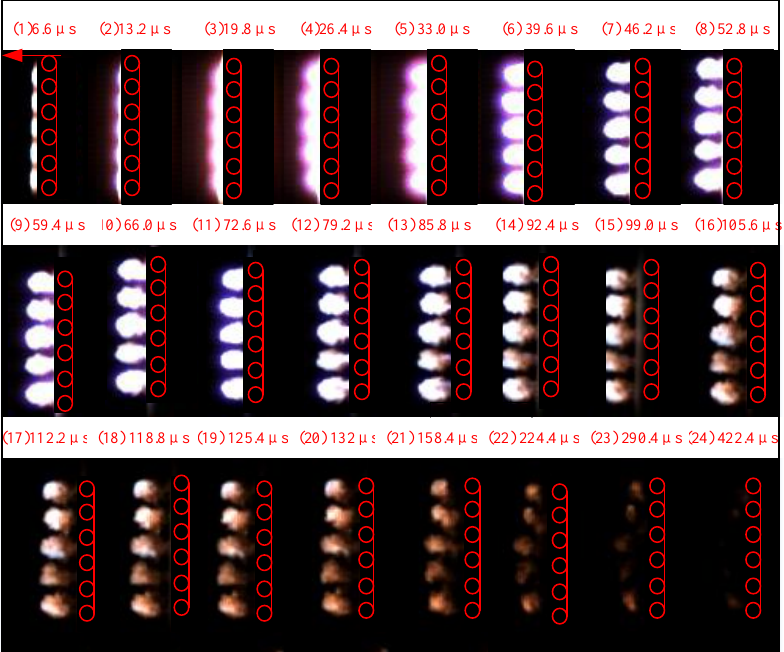
Figure 10 Arc extinction process in the basic multi-chamber structure. Figure 10. Arc extinction process in the basic multi-chamber